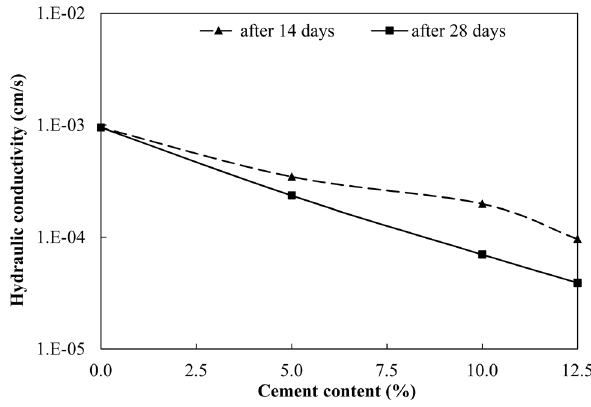
Fig. 11 The permeability graph of CSG material with different cement content after ages of 14 and 28 days